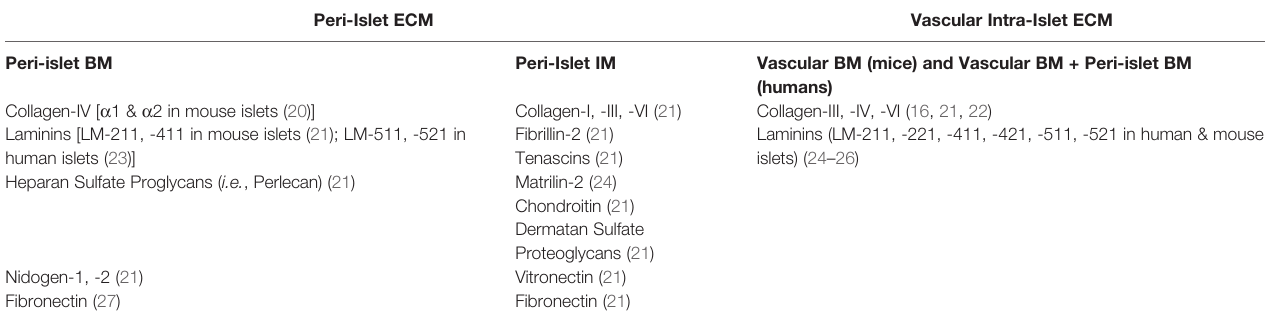
TABLE 2 | Currently identi fi ed major ECM types in adult pancreatic islets. Species-speci fi c information is included in the table when appropriate with literature